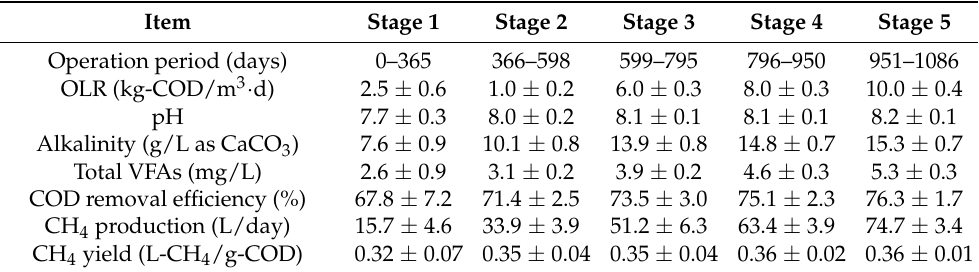
Table 1. Methane production and yield in BEAD reactor during the total operation